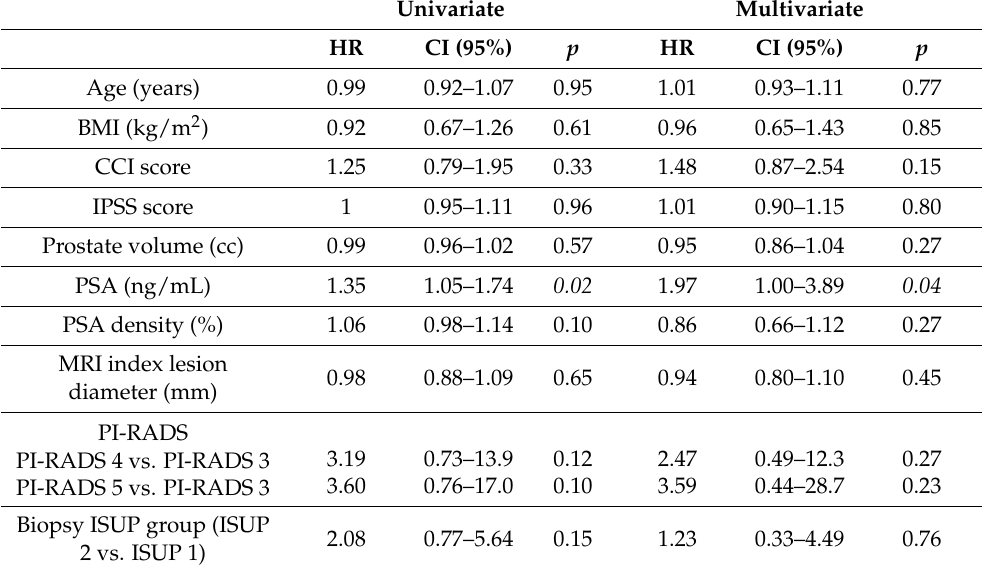
Table 2. Uni- and multivariate logistic regression analysis on failure